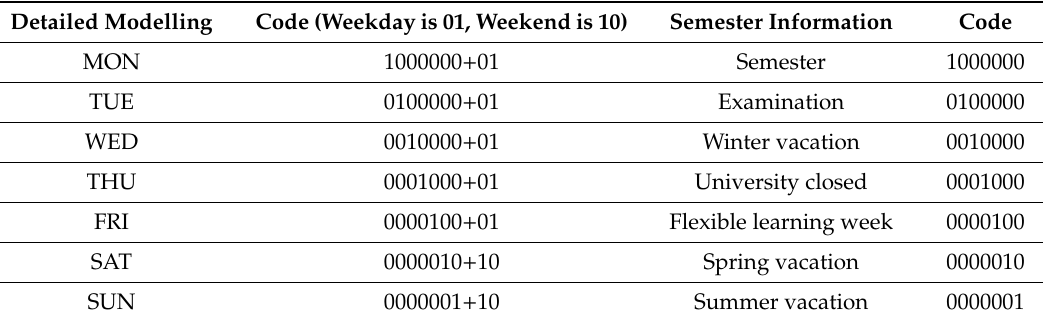
Table A3. Detailed schedule